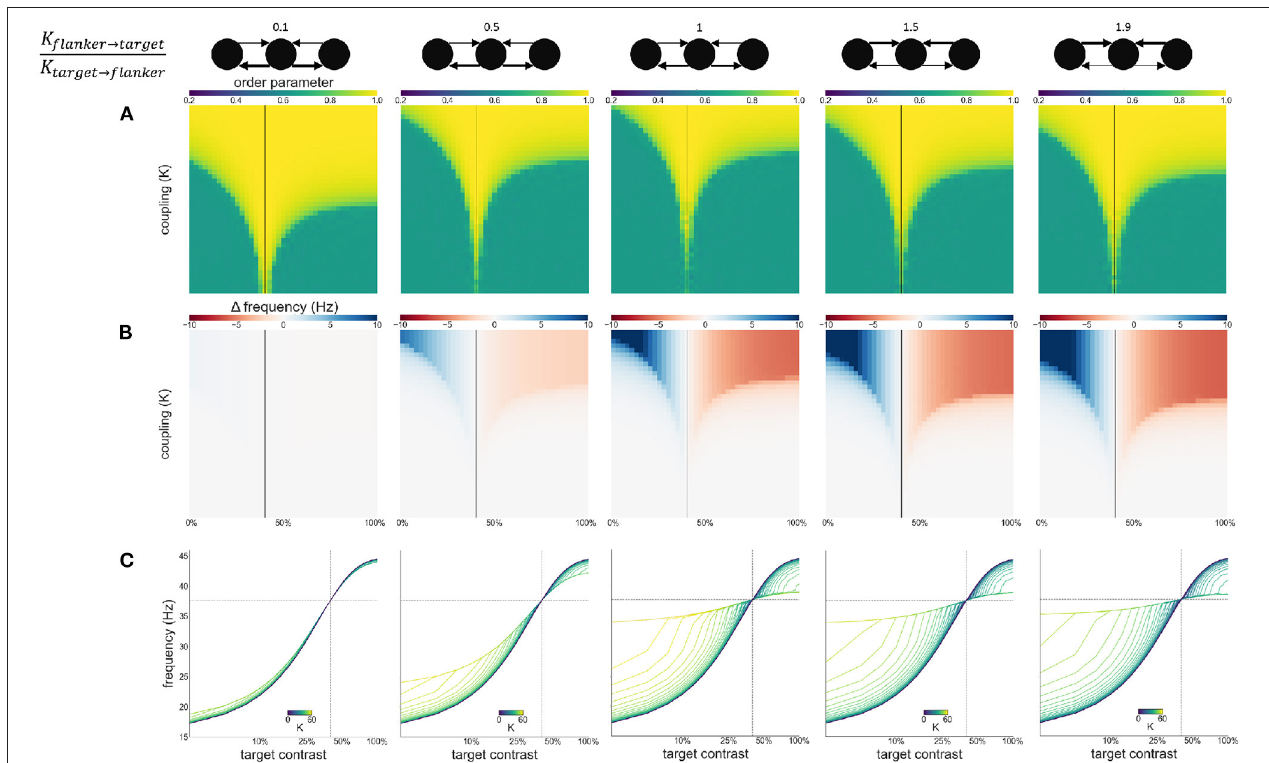
FIGURE 9 | Effects of varying directed coupling ratio between targets and flankers. Ratio increases from left to right. Ratios are given at the top of the figure together with illustrations of the relevant connections. Formatting of each column is identical to Figure 3 : (A) Arnold tongue (B) difference mean effective frequency and intrinsic frequency of target (C) firing frequency of the